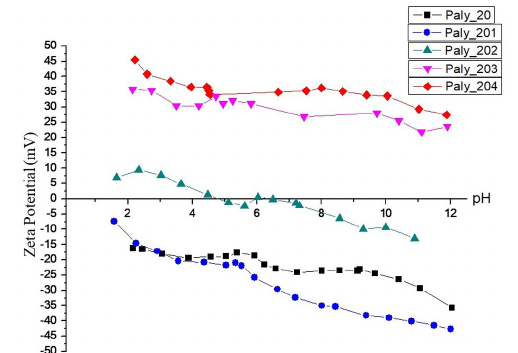
Figure 1. Zeta potential of dressed palygorskite (PALY_20) and organo-palygorskites (PALY_201, PALY_202, PALY_203 and